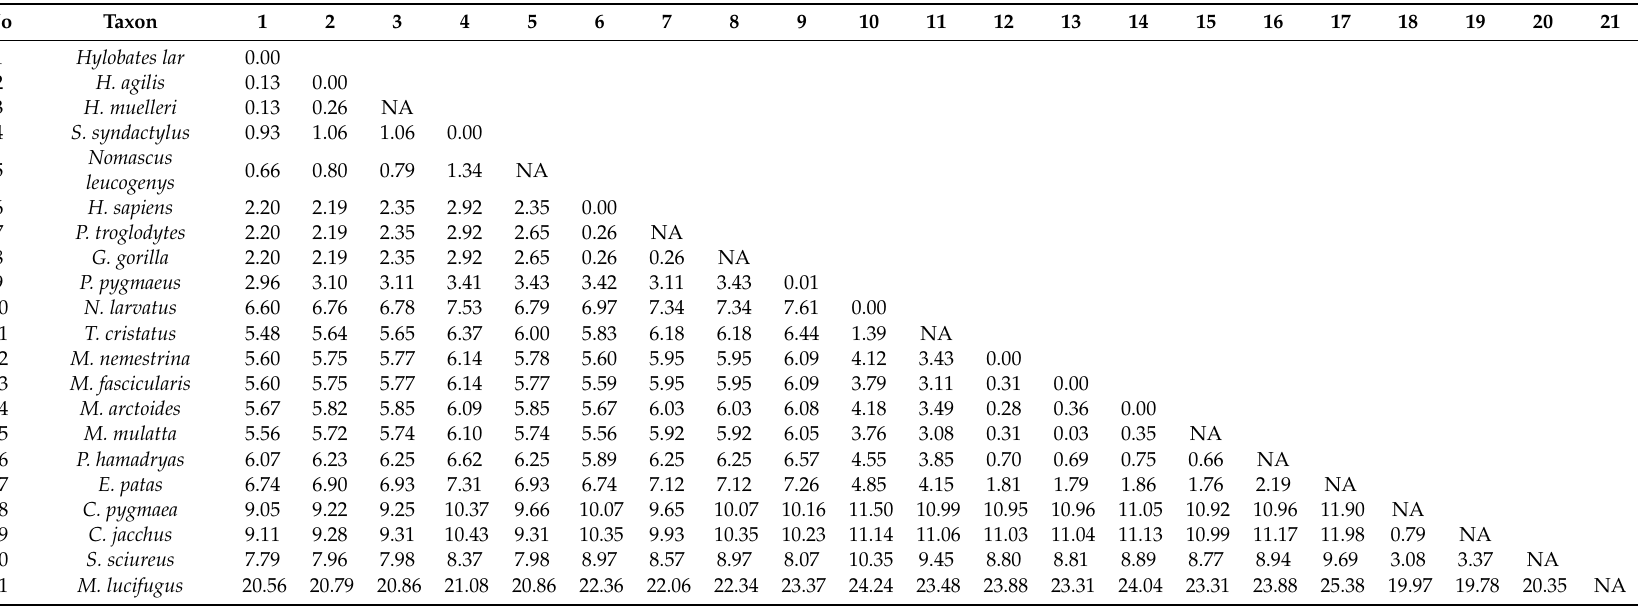
Table 3. Estimates of evolutionary divergence (%) using the Kimura two-parameter model based on TAS1R2 gene sequences. Distance values within and among species of primates are